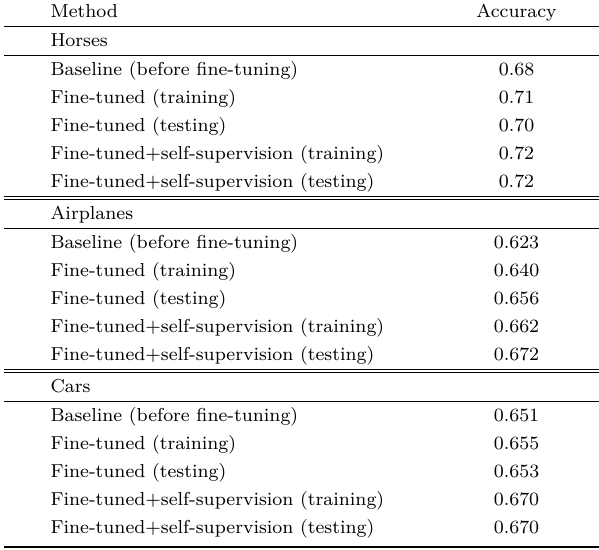
Table 2 Domain specialization evaluation: AUC scores on the object- specific datasets provided by Ref. [32] before fine-tuning the network (baseline), after fine-tuning the network on patches from the dataset (fine-tuned), and after fine-tuning the network using our self-supervision technique